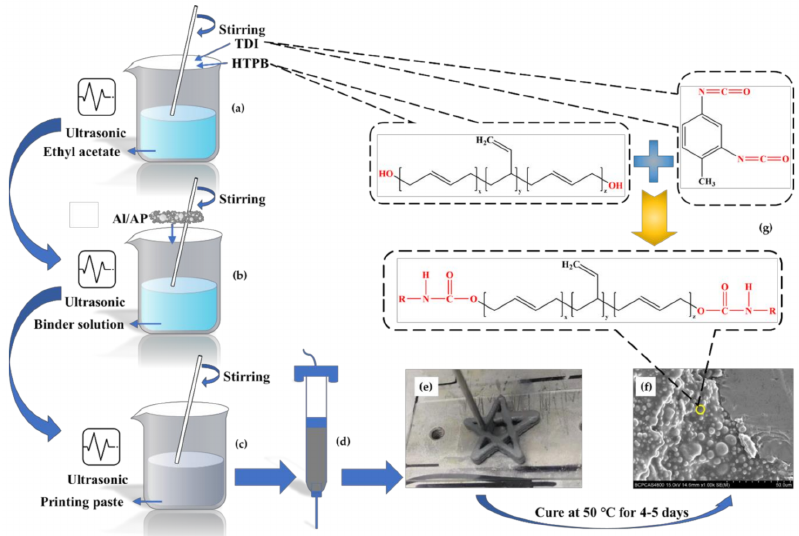
Figure 2. Schematic diagram of slurry preparation and curing mechanism of 3D printing. ( a ) TDI and HTPB were added to ethyl acetate; ( b ) Al/AP was added to the binder solution; ( c ) stir all components for 4 hours; ( d ) transfer the stirred slurry to the syringe; ( e ) install the syringe on the 3D printer and start printing; ( f ) after curing, the internal components are closely connected; ( g ) reaction mechanism of TDI and